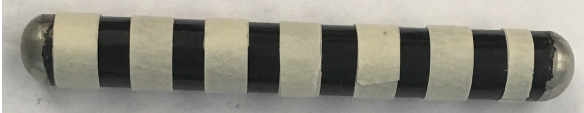
Figure 7. Surface painting process (black color) and markers set- ting (white